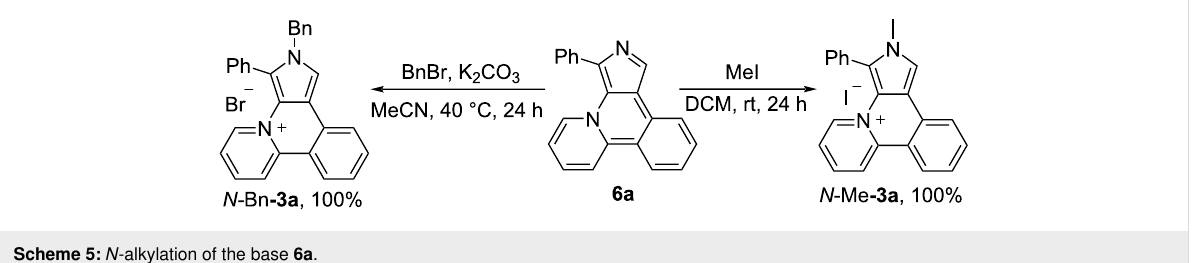
Scheme 5: N -alkylation of the base 6a .